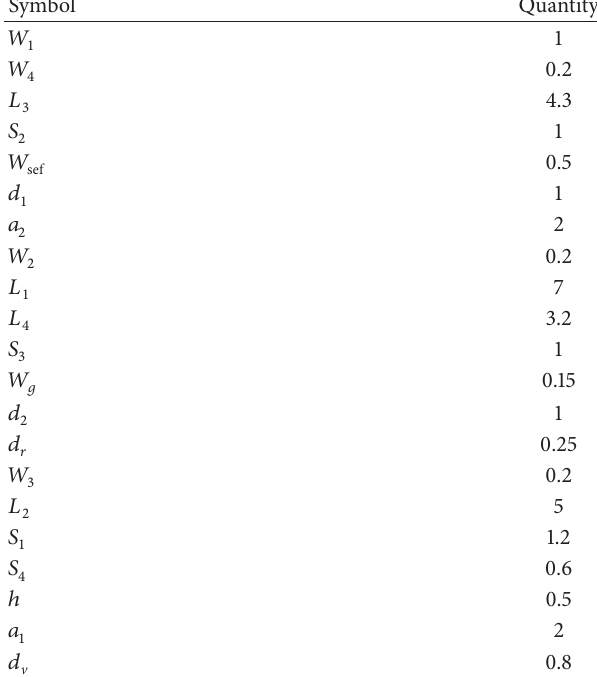
Table 1: Dimensions of CBCPW PLPDA